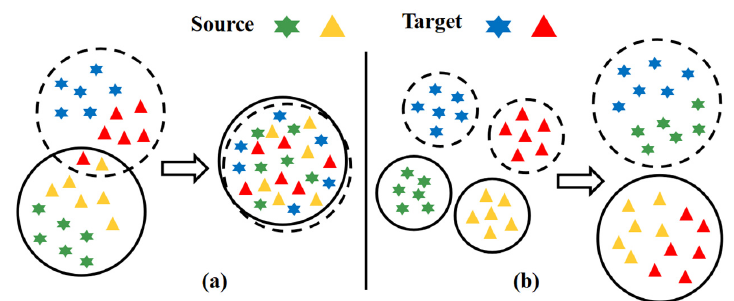
Figure 1. Results of different methods on domain adaptation problem. ( a ) target domain adapta- tion based on global domain adaptation method; ( b ) target domains adaptation based on related subdomain adaptation method.